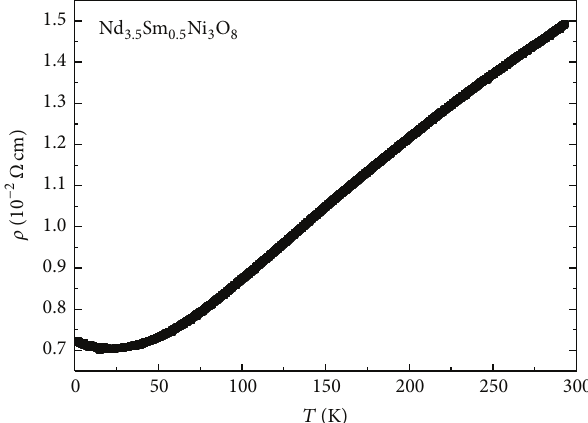
Figure 3: XRD data for Nd 3.5 Sm 0.5 Ni 3 O 8 S 0.68 . Tick marks and bottom solid line are Bragg positions and difference between calculated and observed data, respectively.